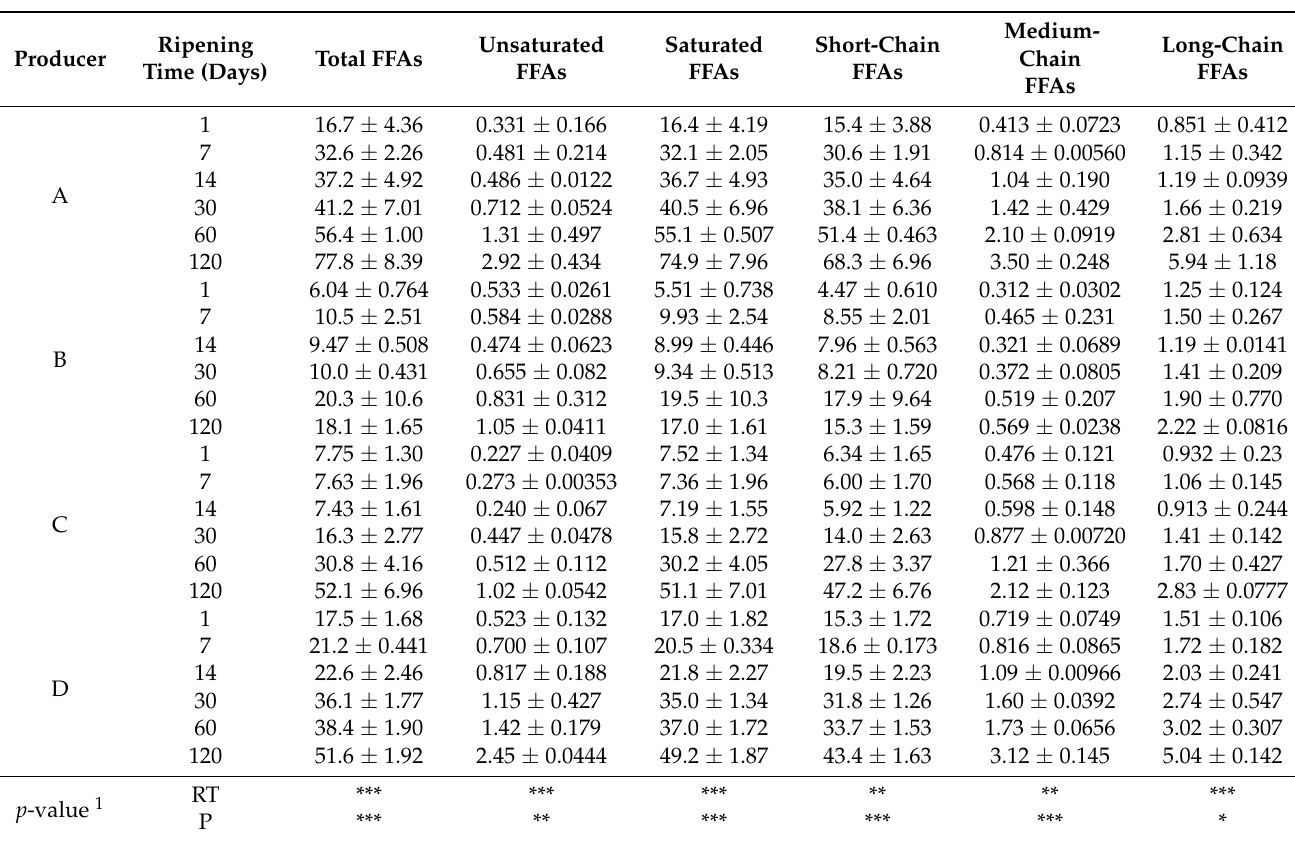
Table 1. Mean concentration ± standard deviation ( µ mol/g) of total, unsaturated, saturated, short-, medium- and long-chain FFAs of Idiazabal cheese analysed from four producers (A, B, C and D) at six time points during ripening (1, 7, 14, 30, 60 and 120 days) ( n =